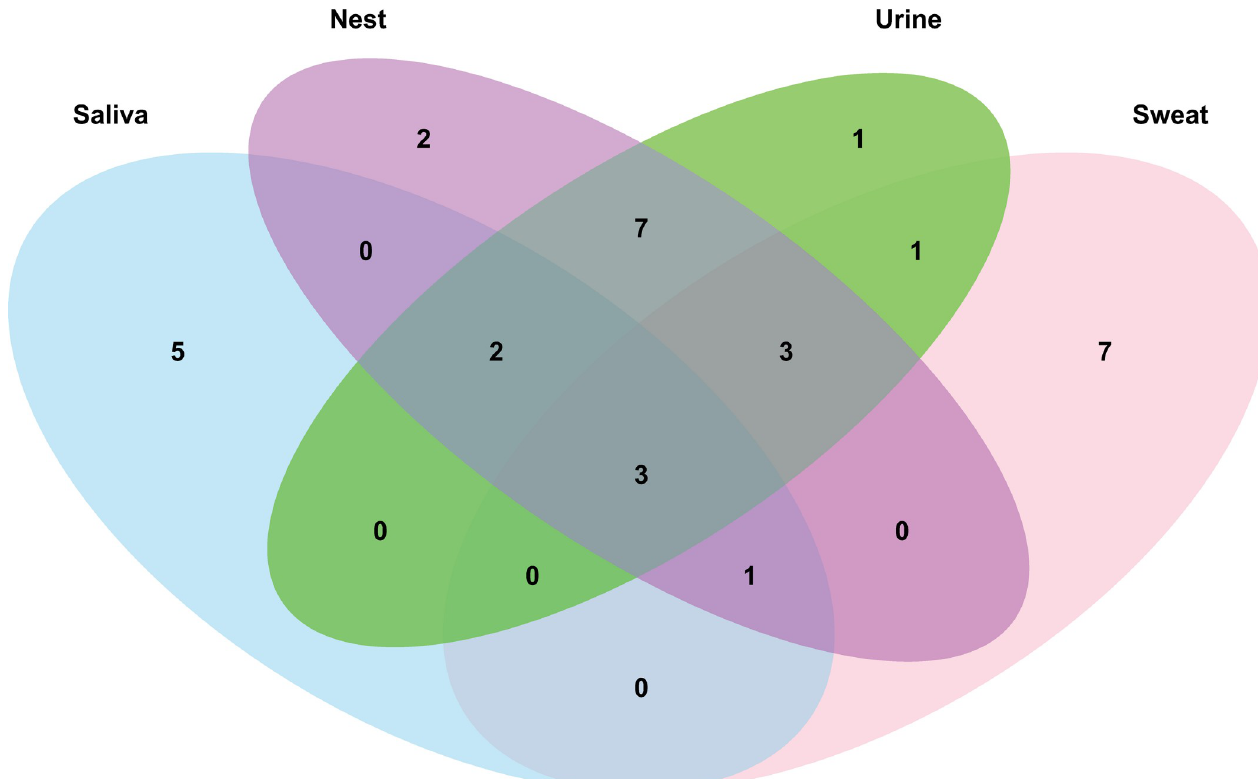
Fig 1. Venn diagram of the number of volatile organic compounds detected in each sample type.